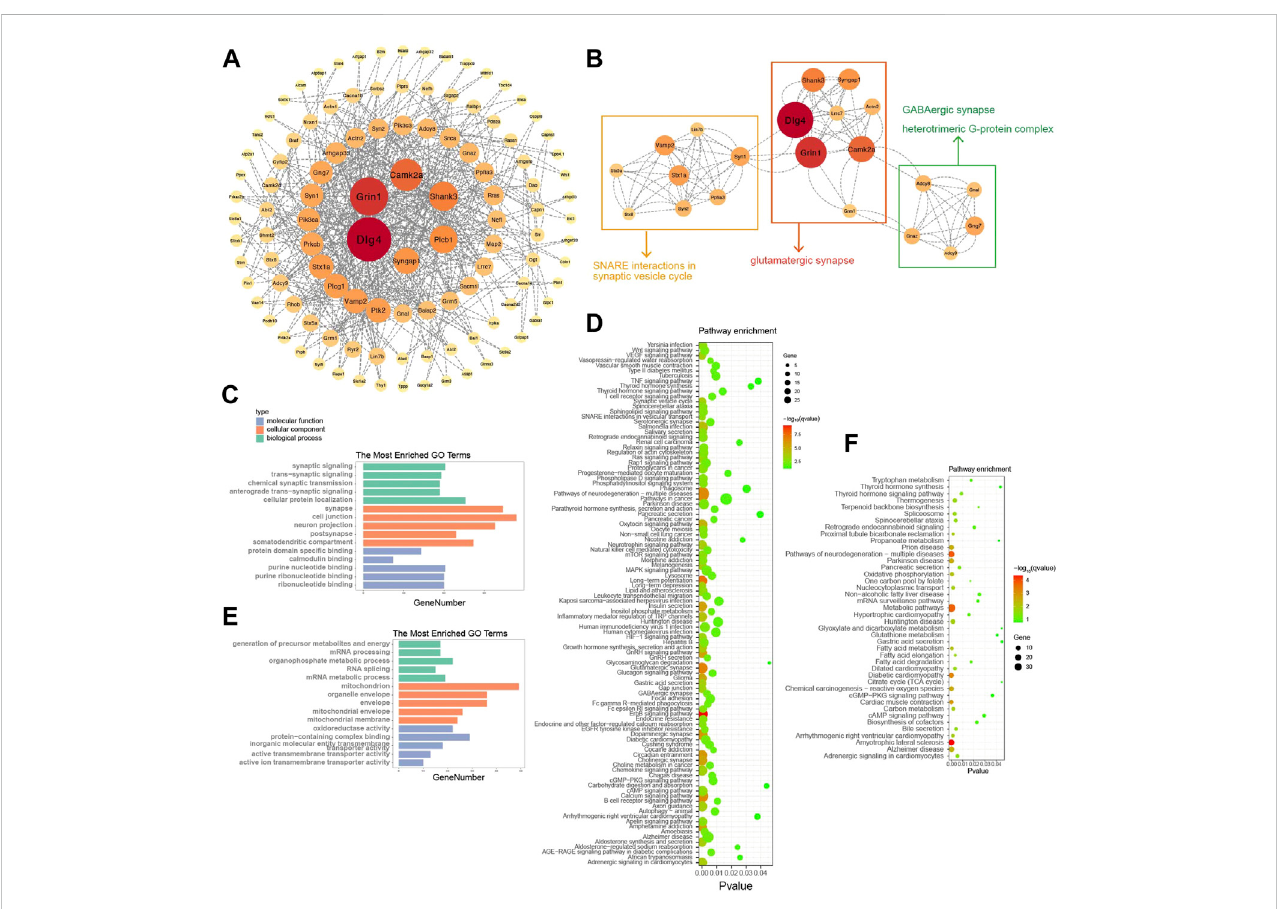
FIGURE 6 Identi fi cation of hub proteins related to diazepam treatment. (A) PPI network construction of 365 DEPs related to diazepam treatment. (B) The most signi fi cant MCODE cluster with 21 nodes and 114 edges. (C) Top 15 GO functional annotations of upregulated DEPs in Diazepam Group compared with Withdrawal Group. (D) KEGG pathway enrichment analysis of upregulated DEPs in Diazepam Group compared with Withdrawal Group. (E) Top 15 GO functional annotations of downregulated DEPs in Diazepam Group compared with Withdrawal Group. (F) KEGG pathway enrichment analysis of downregulated DEPs in Diazepam Group compared with Withdrawal